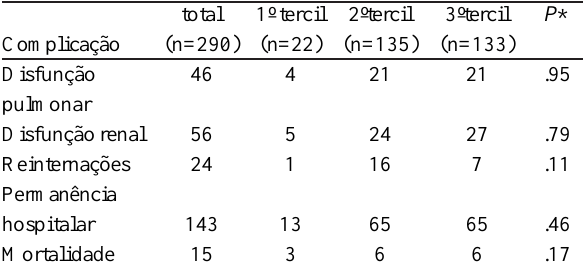
Tabela 3. Distribuição das complicações pós-operatórias por categoria de